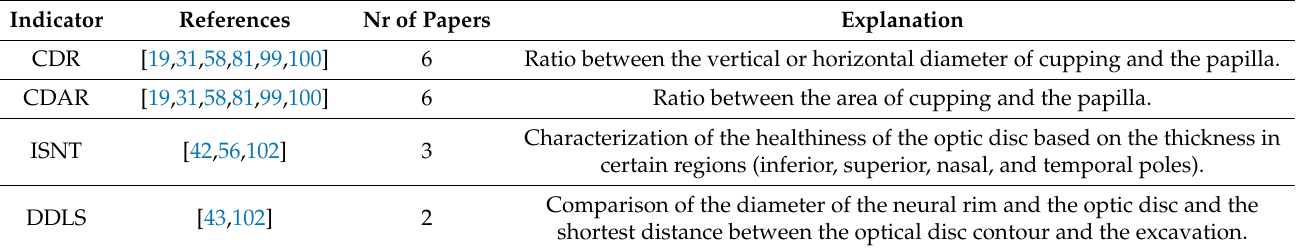
Table 4. Summary of indicators of the presence of